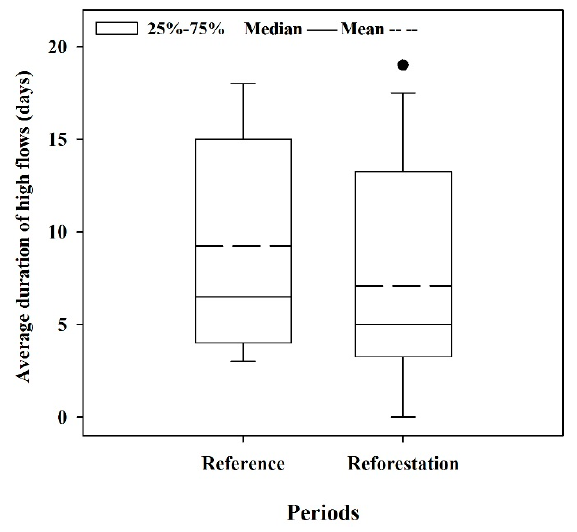
Figure 5. Reference period vs. reforestation period: comparison of the duration of high flows